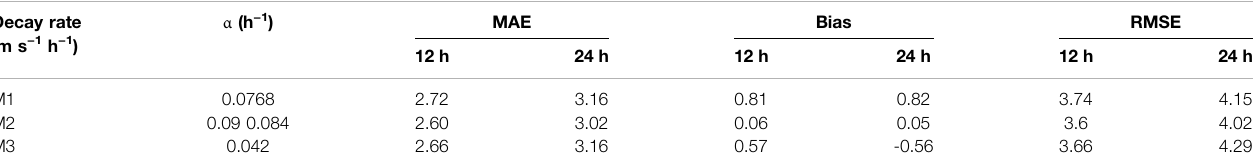
TABLE 1 | The decay rate, mean absolute error (MAE), bias and root-mean-square error (RMSE) from M1, M2, and M3 during the fi rst 12 h or 24 h after landfall. Decay rate (m s − 1 h − 1